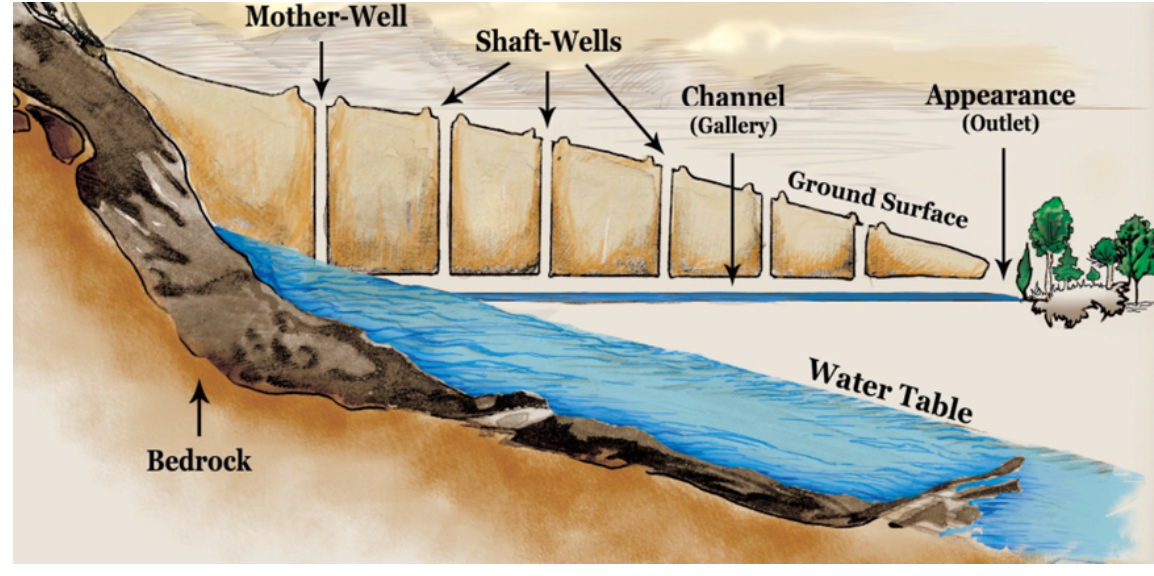
A qanat profile. Courtesy ICQHS. FIG.